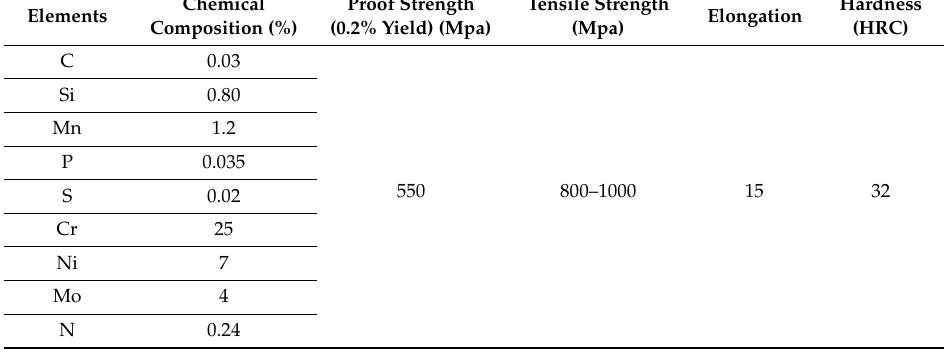
Table 1. Chemical composition and mechanical properties of S32750.